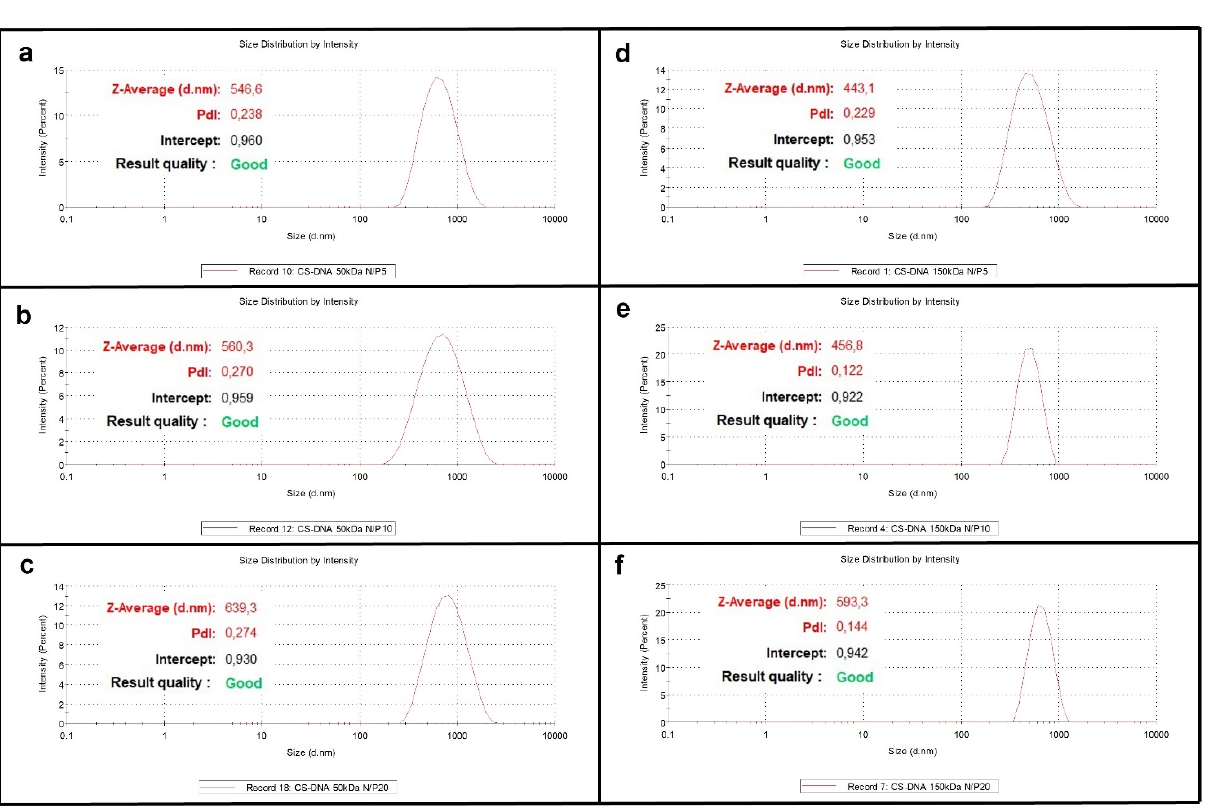
Table 4. Z-potential (mV) of CS/hsDNA complexes prepared with CS of different molecular weights and at different N/P values.